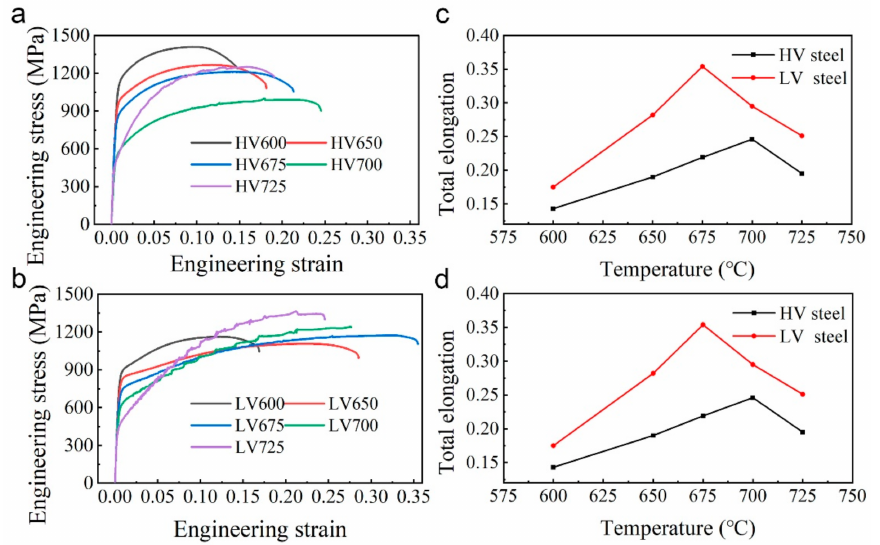
Figure 6. Mechanical properties of HV and LV samples at different annealing temperatures: engi- neering stress–strain curves of ( a ) HV steels and ( b ) LV steels; ( c ) yield strength curves and ( d ) total elongation